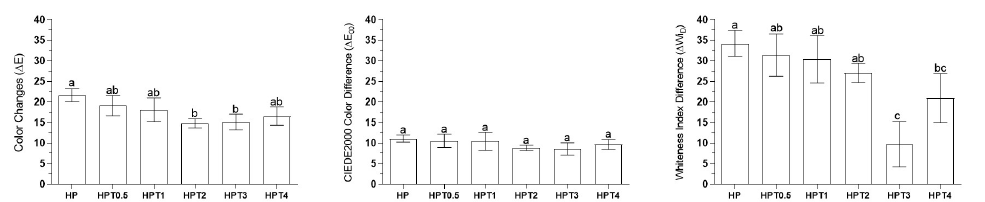
Figure 2. Color change ( ∆ E ab ), CIEDE2000 color difference ( ∆ E 00 ), and whiteness index difference ( ∆ WI D ) after bleaching treatment. Legend: Means and standard deviation followed by different letters indicate statistical differences according to one-way ANOVA and LSD post hoc test with significant level set at 5%. Lowercase letters compare bleaching treatment groups. N = 10 specimens/group. HP: hydrogen peroxide; T: titanium tetrafluoride.